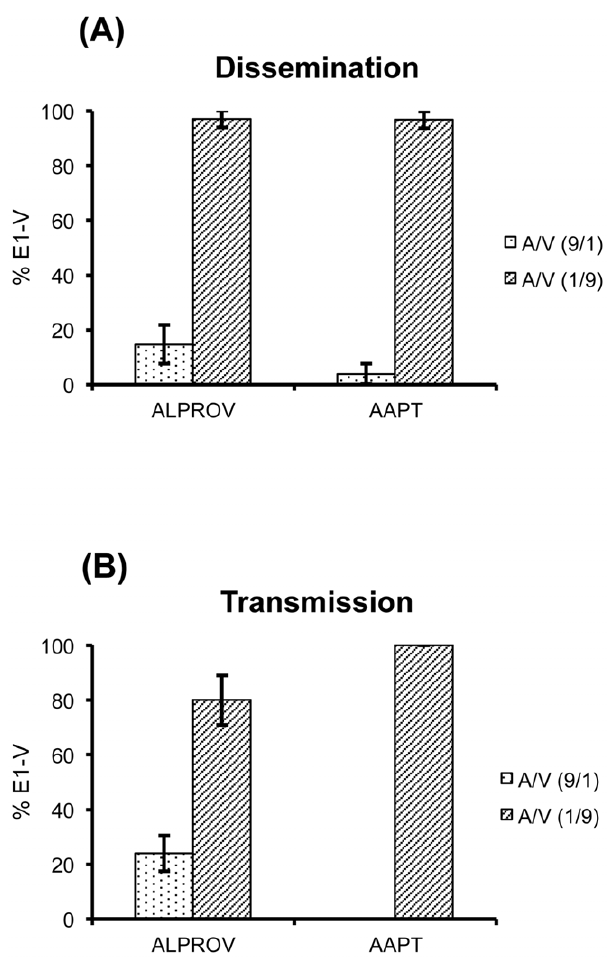
Figure 5. Unbalanced proportions of E1-226V and E1-226A provided in blood-meals to Ae. aegypti (AAPT) and Ae. albopictus (ALPROV). Ae.aegypti and Ae.albopictus were given an infectious blood-meal containing unbalanced proportions of two clones E1-A and E1-V isolated from the strains E1-226A and E1-226V, respectively. Two mixes were tested: one containing 1:9 (E1-A:E1-V) and one containing a mix of 9:1 (E1-A:E1-V). At day 7 post-infection, dissemination (A) and transmission (B) were examined by estimating the proportion of E1-V in wings and saliva, respectively, of five individual females. Error bars show the confidence intervals